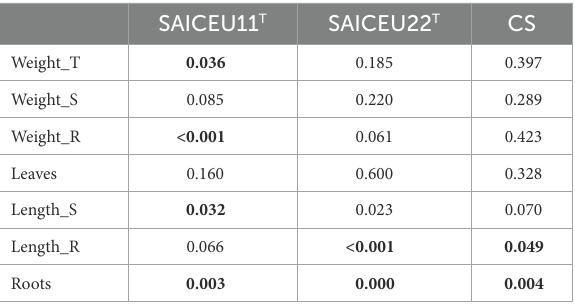
TABLE 4 Significance of the differences between values (value of p ) after the ANOVA analysis, for each bacterial treatment and